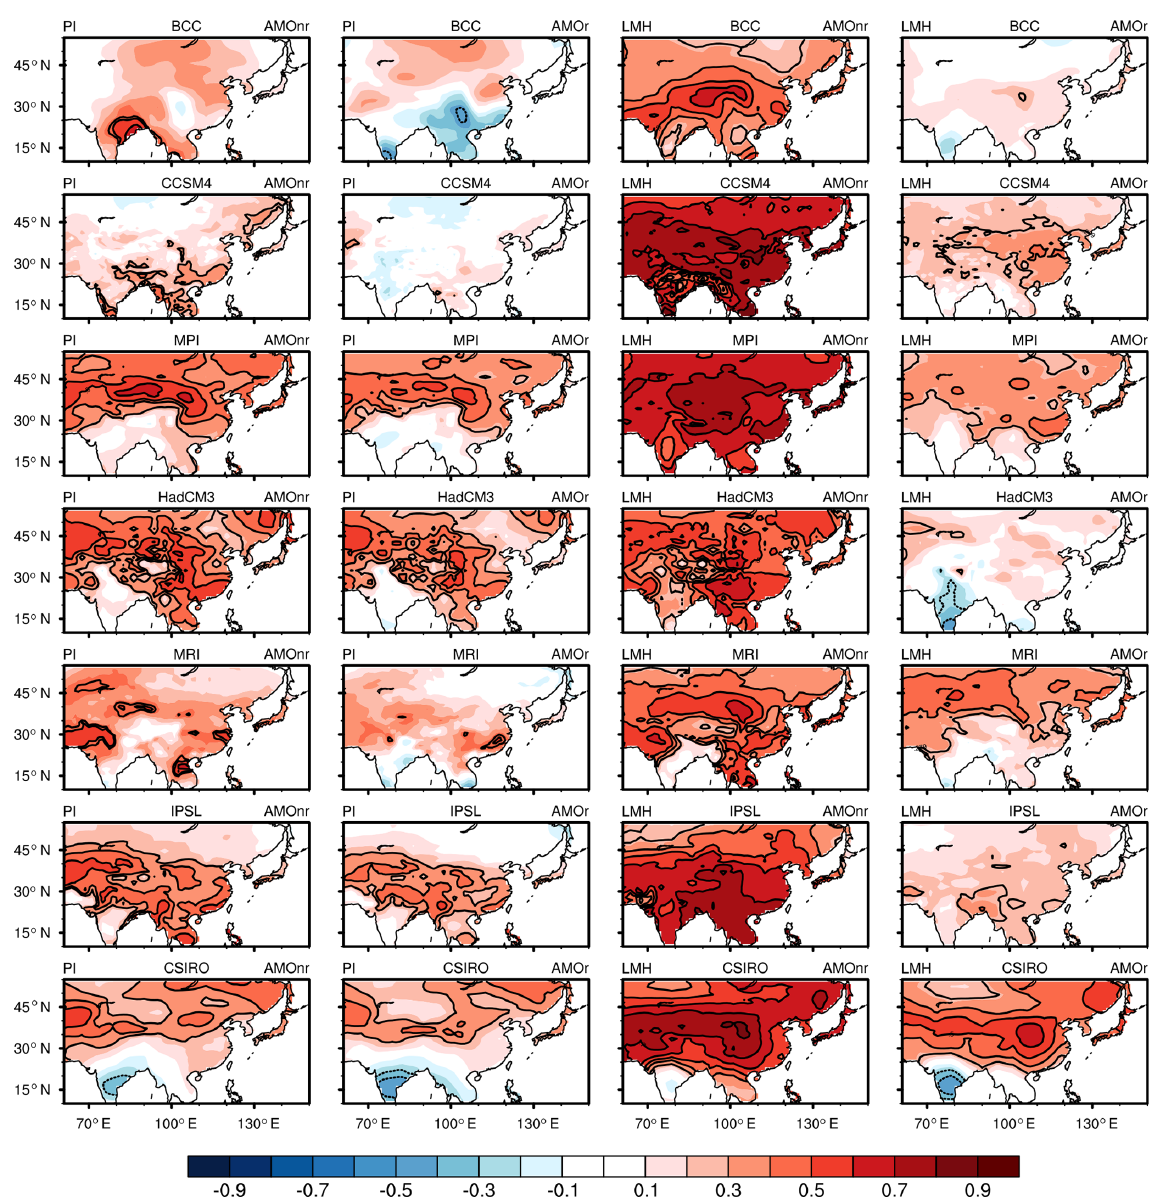
Figure 3. Correlations between annual-mean East Asian surface temperatures and AMO index for each GCM for PI (first and second columns) and LMH (third and fourth columns) experiments. AMOnr and AMOr are the two definitions of AMO index as described in Fig. 1. Correlation values significant at 90% levels using a two-tailed Student’s t test are